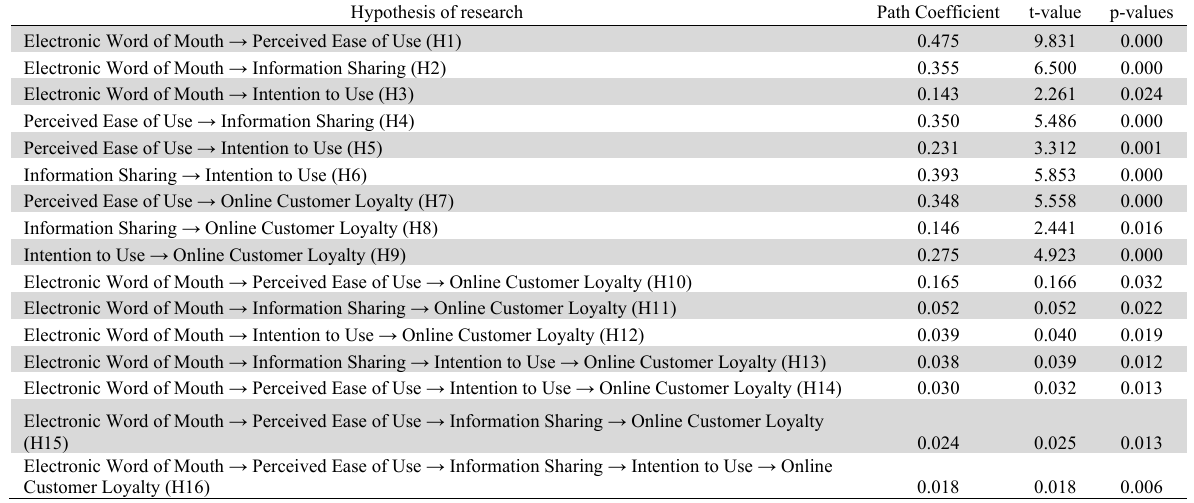
Direct and Indirect Effect Output PLS